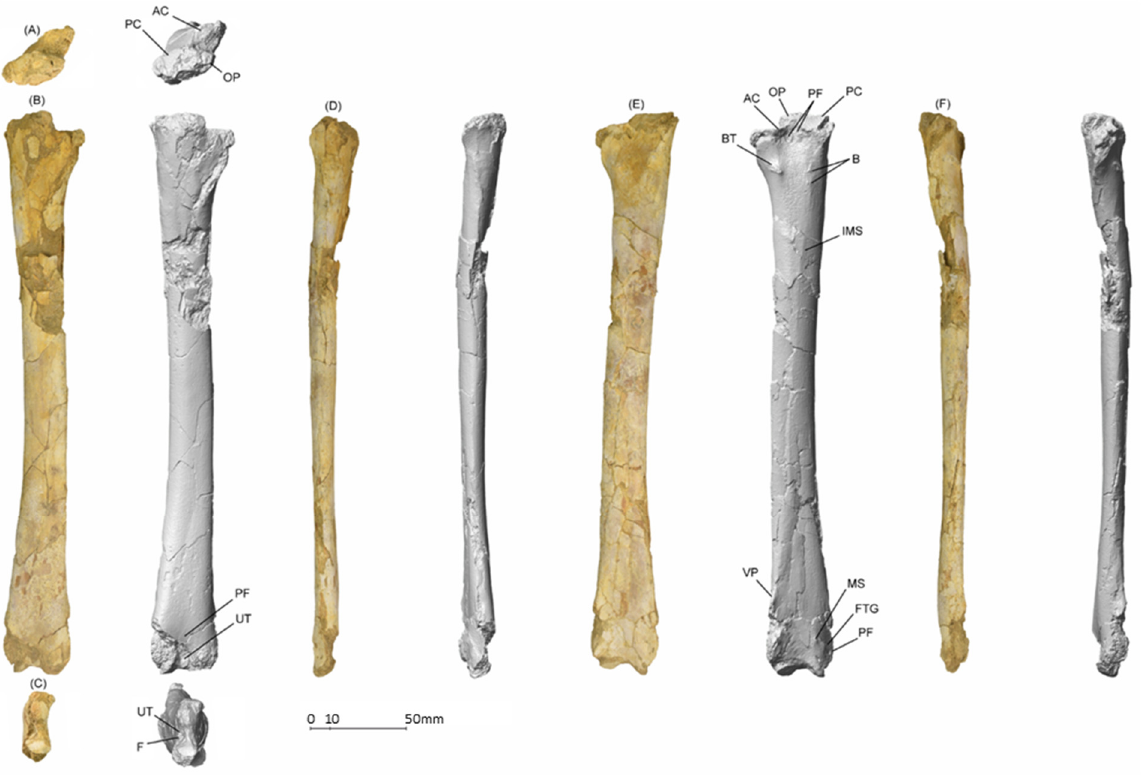
Figure 4. Holotype MGUAN-PA650 Epapatelo otyikokolo , gen. et sp. nov. left ulna. ( A ) proximal, ( B ) posterior, ( C ) distal, ( D ) dorsal, ( E ) anterior, and ( F ) ventral views. Abbreviations: AC, anterior cotyle; B, bump; BT, biceps tubercle; F, fovea; FTG, flexor tendon groove; MS, muscle scar; OP, olecranon process; PC, posterior cotyle; PF, pneumatic foramen; and UT, ulnar tubercle; IMS, interosseous membrane scar; VP, ventral process.